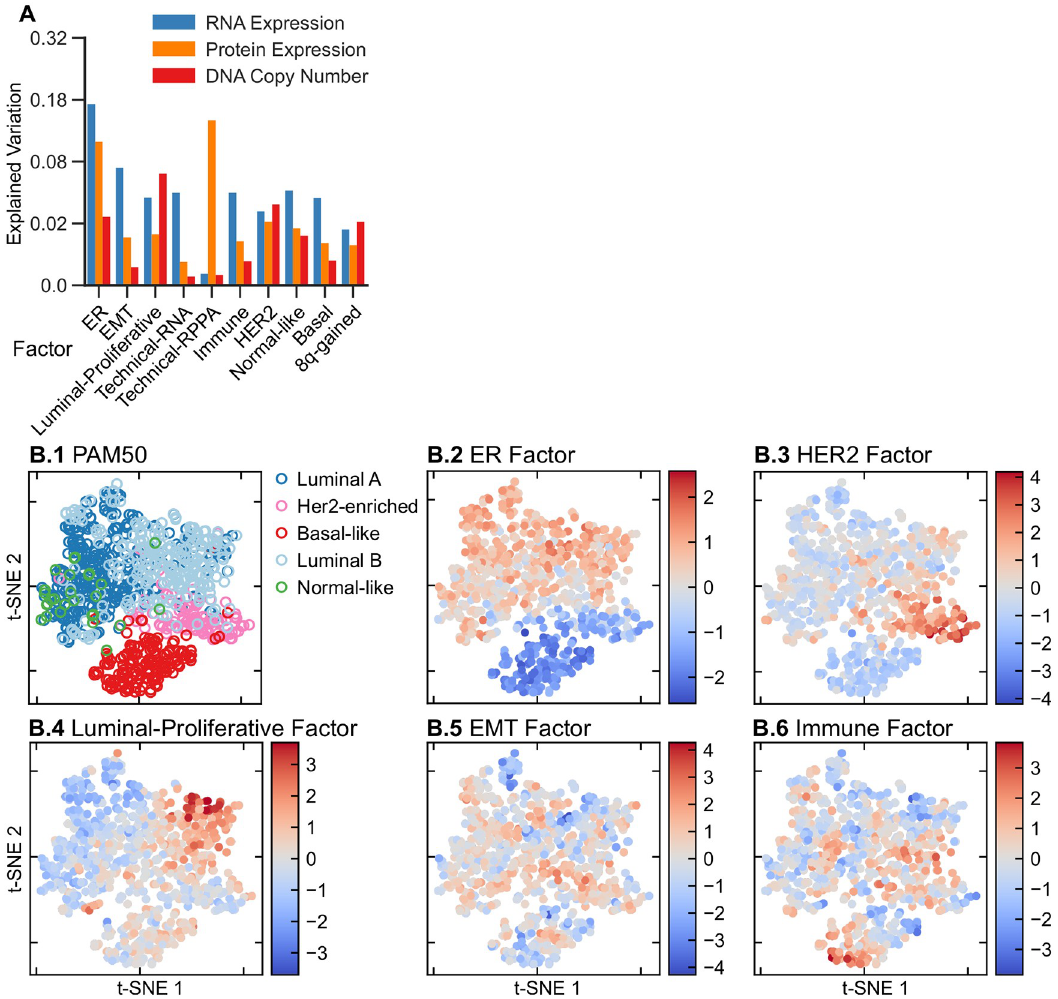
Fig 3. Sparse-factor analysis on the TCGA breast cancer data set. A: Explained variation per data type and factor. B: The top-left panel shows a t-SNE map of the tumors with the different colors showing PAM50 subtypes. The remaining panels show the tumors in the same positions as the PAM50 map, but colored according to the value of the represented factor in each tumor.